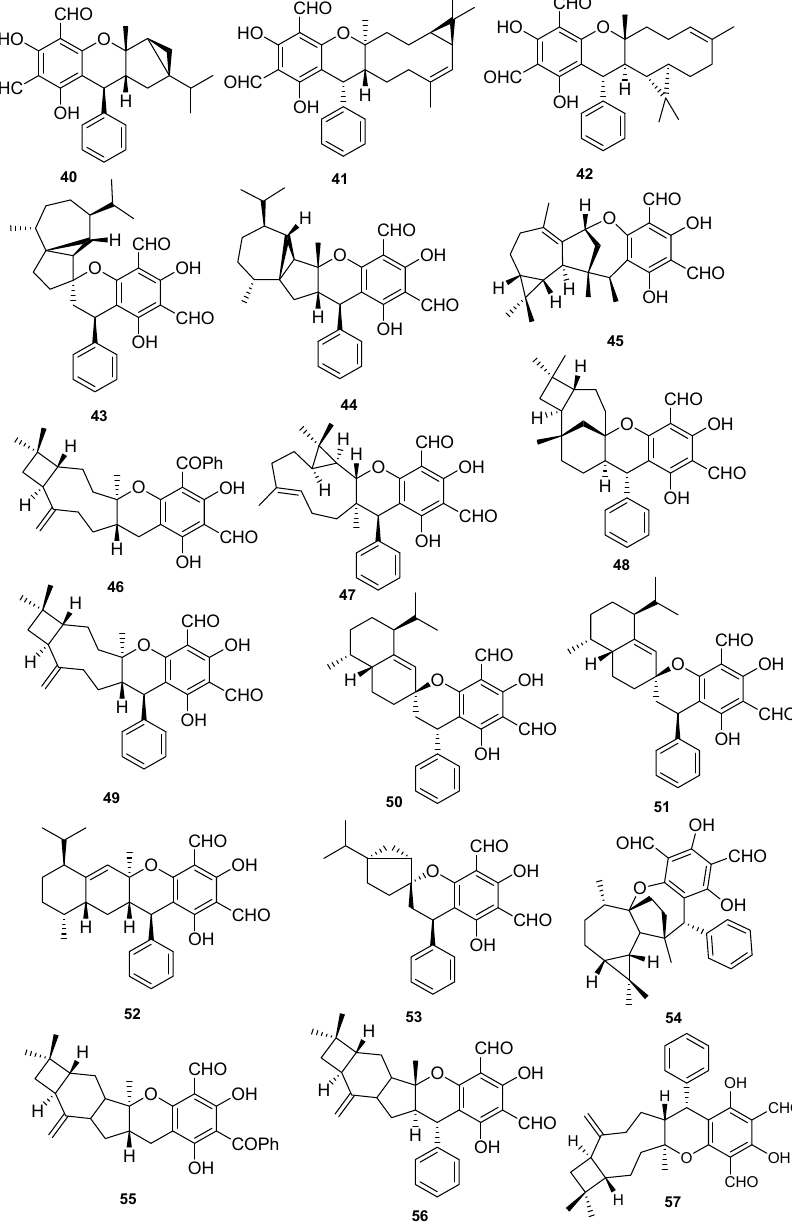
Figure 5. Meroterpenoids isolated from P. guajava L.